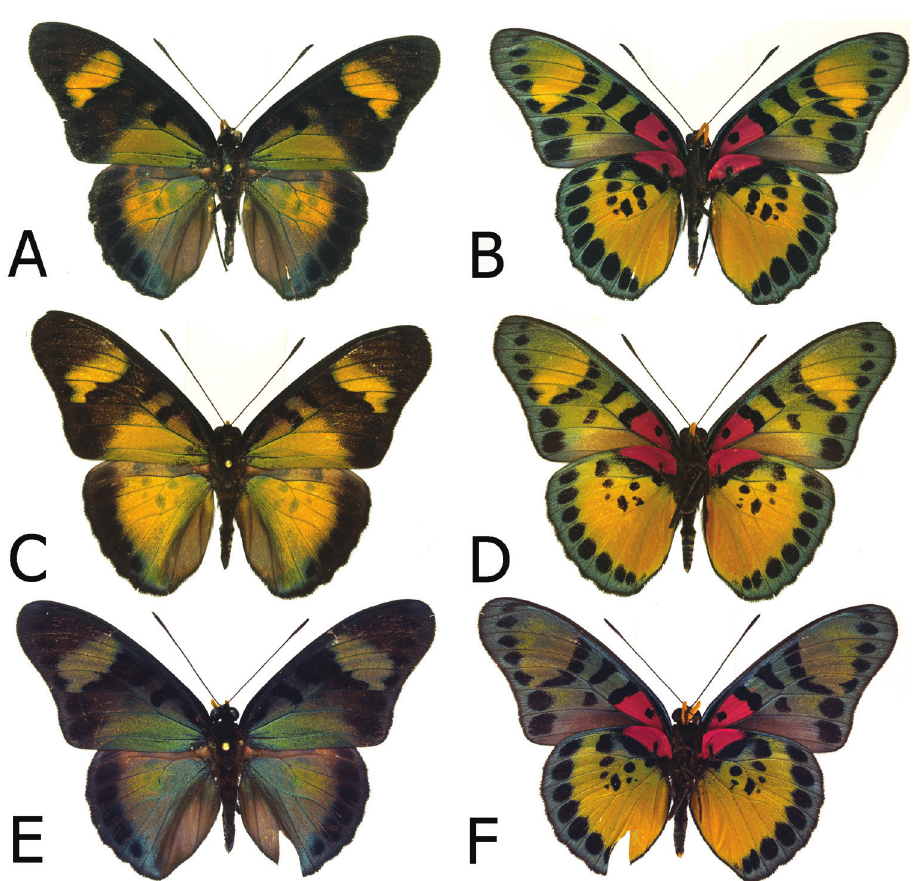
Figure 5. Adults, males: A E. sarcoptera sarcoptera male, Bibiani, Ghana (dorsum) B E. sarcoptera sar- coptera , Bibiani, Ghana (venter) C E. sarcoptera ferrea Mont Nimba, Guinea, holotype (dorsum) D E. sarcoptera ferrea Mont Nimba, Guinea, holotype (venter) e E. sarcoptera styx , Tai, Ivory Coast (dosum) F E. sarcoptera styx , Tai, Ivory Coast